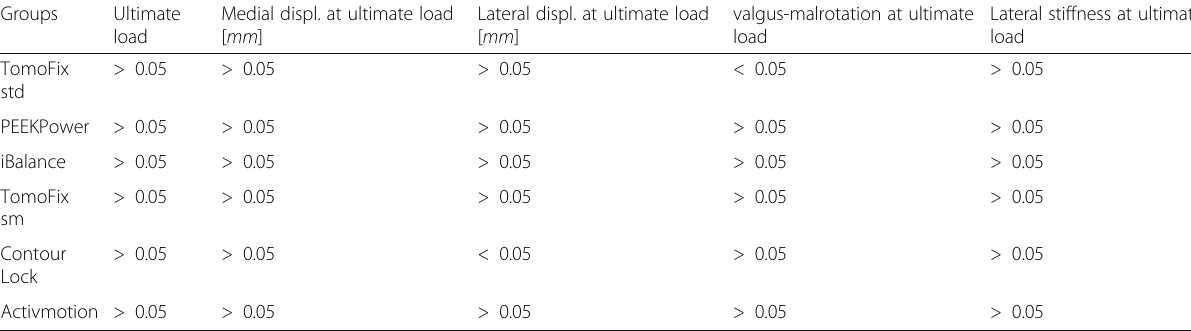
Table 6 p -Values obtained from the t-tests comparing the previously tested implants to the FlexitSystem